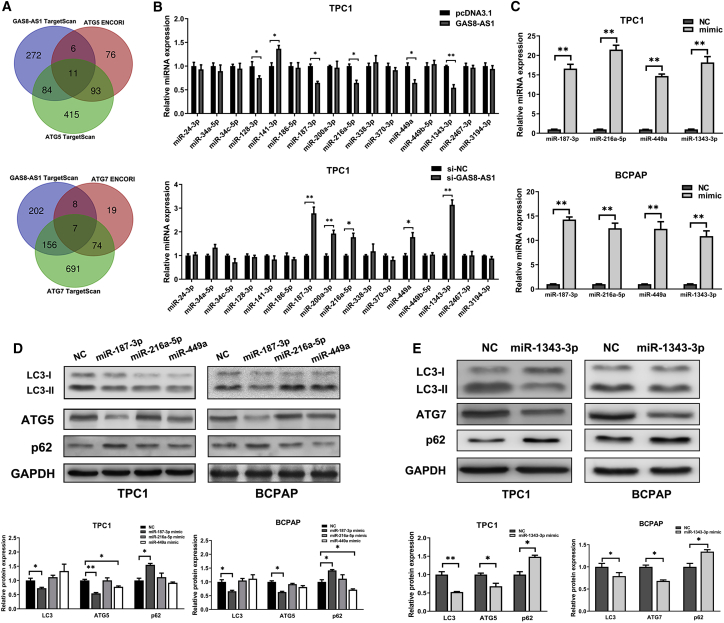
miR-187-3p and miR-1343-3p Targeting Inhibited ATG5 and ATG7 Expression in PTC Cells, Respectively(A) The miRNAs potentially targeting GAS8-AS1, ATG5, and ATG7 were predicted using bioinformatics software. (B) qRT-PCR measurement of the relative expression of the predicted miRNAs after si-GAS8-AS1 or pcDNA3.1-GAS8-AS1 transfection in TPC1 cells. (C) qRT-PCR analysis of overexpression efficiency after miR-187-3p, miR-216a-5p, miR-449a, and miR-1343-3p mimic transfection in PTC cells. (D) Western blotting detection of the autophagy-relevant proteins (LC3, ATG5) after miR-187-3p, miR-216a-5p, and miR-449a mimic transfection in PTC cells. (E) Western blotting detection of the autophagy-relevant proteins (LC3, ATG7) after miR-1343-3p mimic transfection in PTC cells. Statistical differences were analyzed using the independent samples t test; data are shown as the mean ± standard error of the mean based on three independent experiments. ∗p < 0.05, ∗∗p < 0.01.